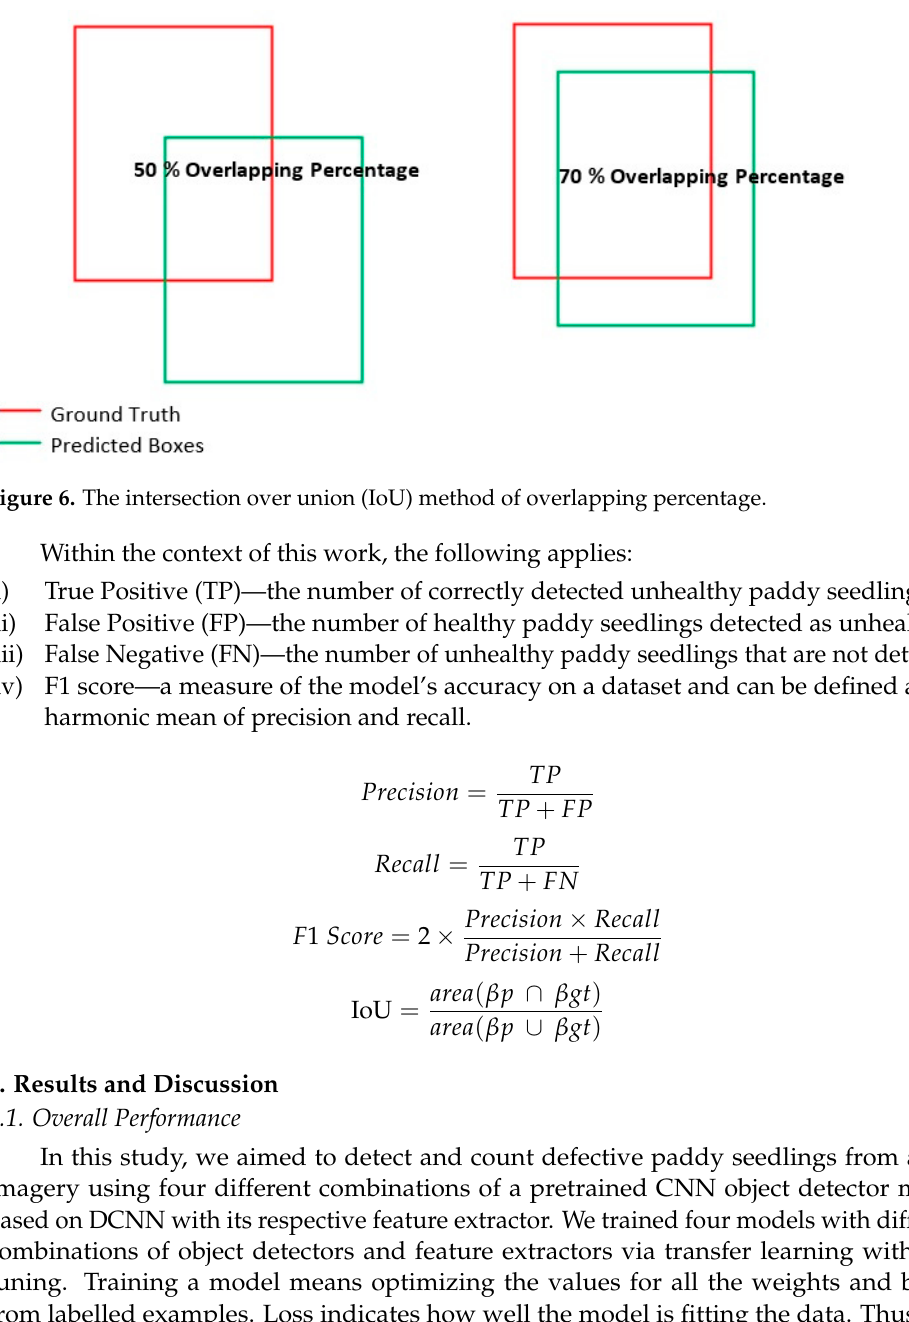
Figure 7. The total loss of each model during the training process.